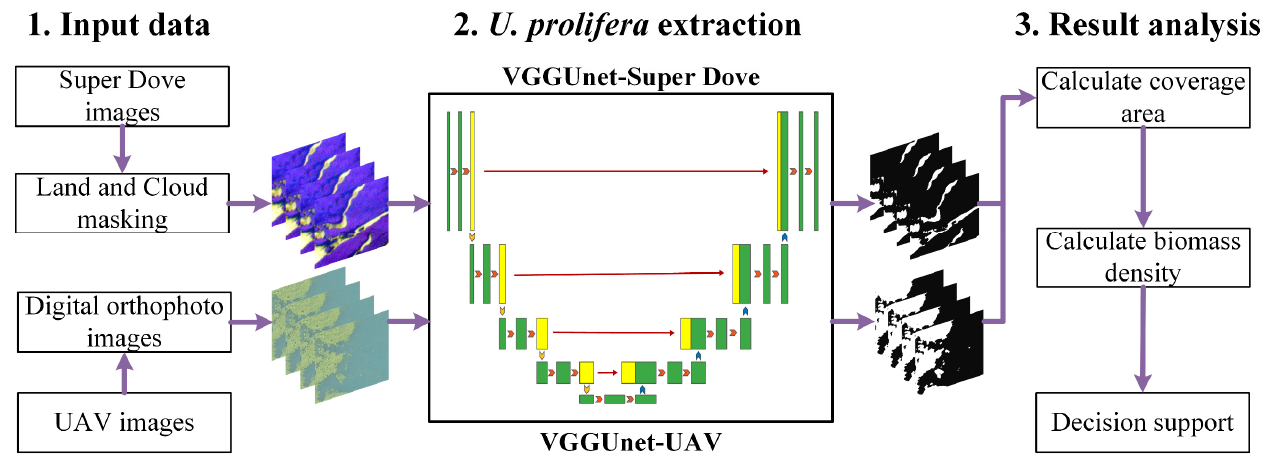
Figure 3. Workflow for the automatic extraction and analysis of U. prolifera using images from both the Super Dove and the UAV.